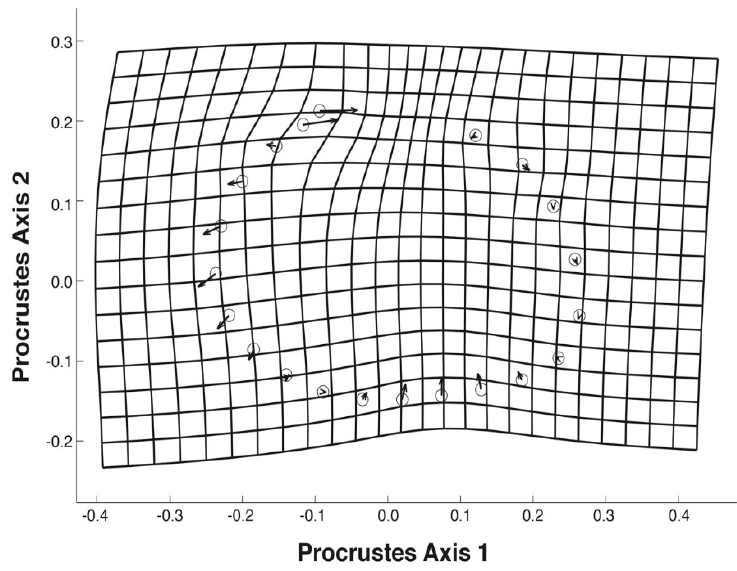
Figure 4. Procrustes deformation grid of shell shape showing differences in mean shell shape between P. sintoxia (circles) and F. flava (ends of vector arrows) along CVA Axis 1 (Figure 3).